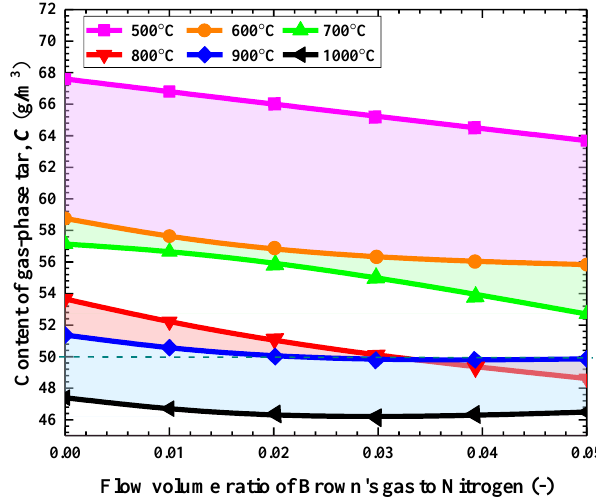
Figure 11. Relationship between the content of gas-phase tar and the flow volume ratio of Brown’s gas to nitrogen in pine wood pyrolysis.